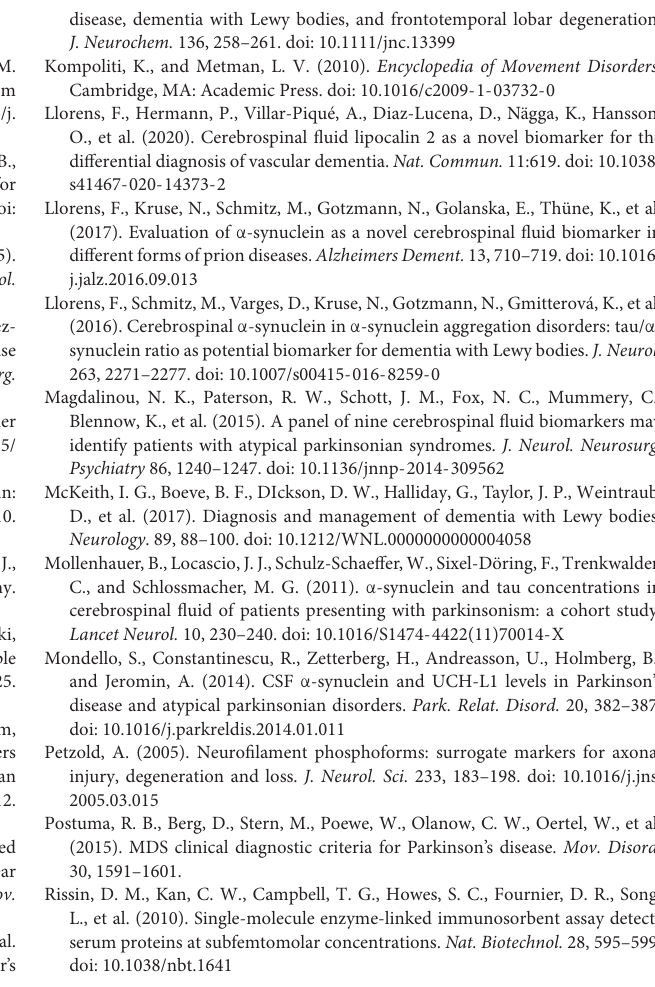
Supplementary Figure 1 | Analysis of intra-assay variations of NfL in CSF. We chose different concentrations (high and low) to compare pairwise the NfL levels measured in duplicates on the same plate (A) . Statistical analysis revealed no significant (ns) between both measurements (B) , p > 0.05. Supplementary Figure 2 | Analysis of a potential correlation between a-Syn levels and age. (A–C) In synucleinopathy patients and controls, we correlated aSyn levels and age. No correlation was detected between all groups. All correlation studies were computed by using the non-parametric Spearman’s correlation test (two-tailed) in a CI of 95%. A ∗ p -value < 0.05 was considered as significant and p ≥ 0.05 as not